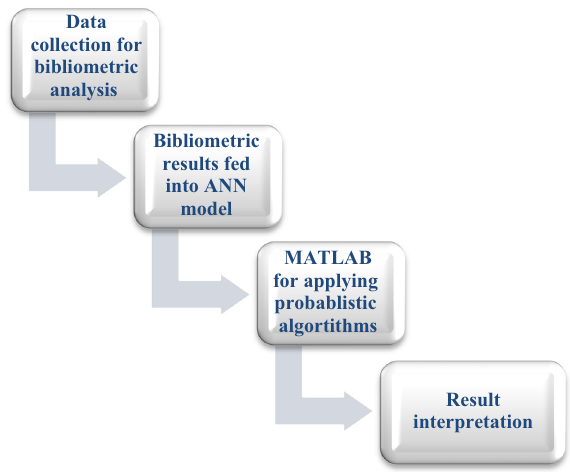
Figure 1: Work fl ow of